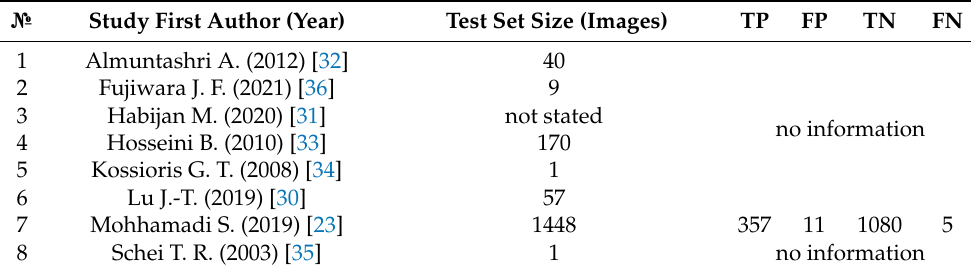
Table 2. Data presence for confusion matrix arrangement 1 .